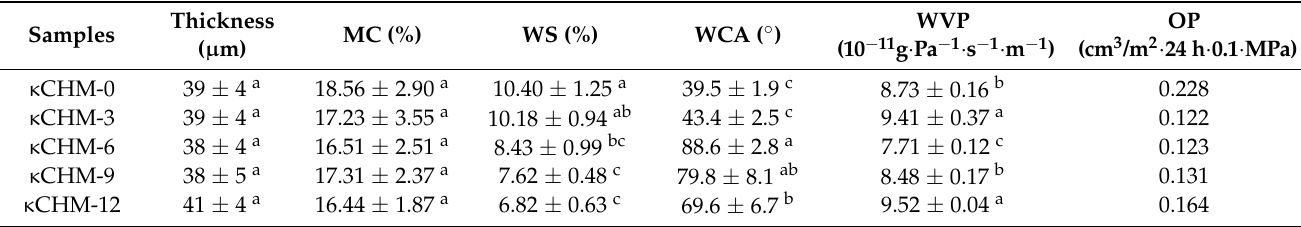
Table 1. Thickness, MC, WS, WCA, WVP and OP of κ CHM films.